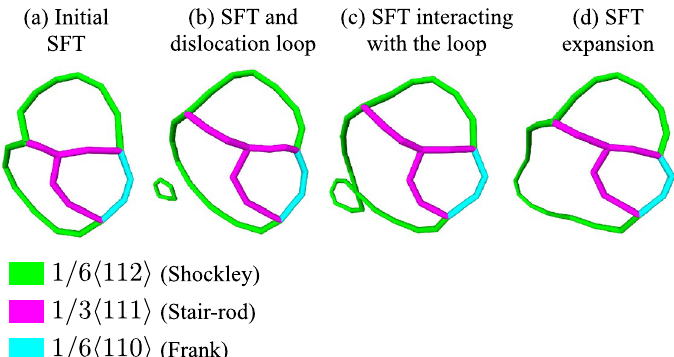
Figure 6. Primary SFT deformation process in irradiated Au. The SFT is isolated from initially-crystalline Si– Au at 0.005 dpa under biaxial compression